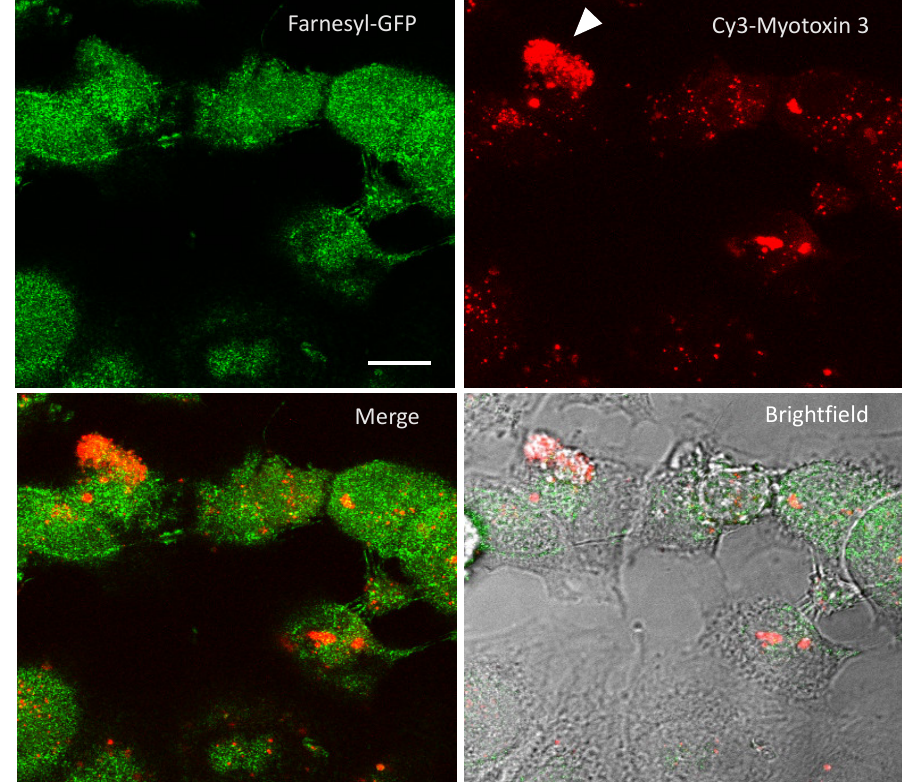
Figure 7. Cy3-myotoxin-3 uptake by MCF7 cells. MCF-7 cells were transiently transfected for farne- sylated-GFP expression to delimit the cell membrane. Cells were then incubated for 1h at 37 °C with labeled Cy3-myotoxin-3 (45-residue isoform, native). After low pH removal of cell-surface-bound peptide, cells were fixated. Images captured by confocal microscopy are presented as a stack of 30 confocal slices. Scale bar = 10 µm.